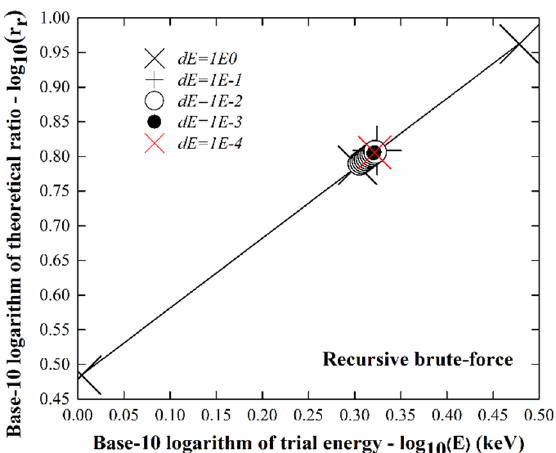
Figure 4. Base-10 logarithm of theoretical ratio r r varies with that of trial characteristic energy E for the Figure 4 Base-10 logarithm of theoretical ratio (cid:1870) (cid:3045) varies with that of trial characteristic energy (cid:1831) for recursive brute-force the recursive brute-force approximation.